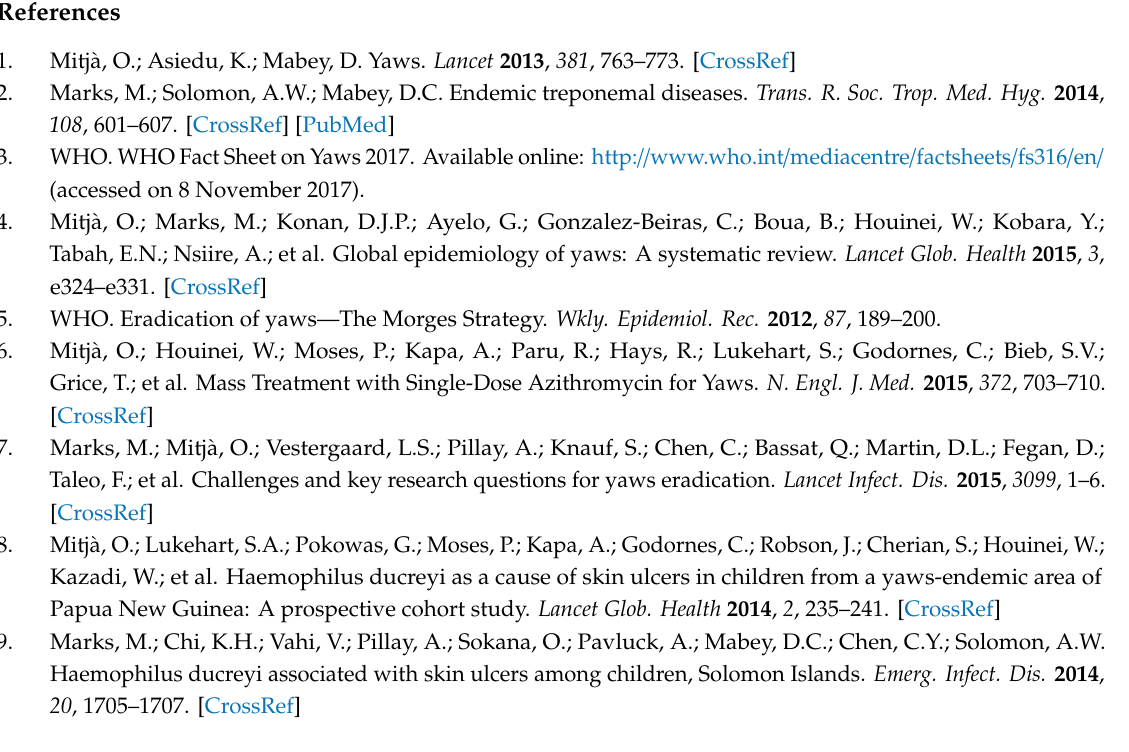
Figure S1: Primer combination testing for PolA of T. pallidum, Figure S2: Primer combination testing for hhdA of H. ducreyi , Table S1: Sequences for all Primers and Probes Used in the Assay Development, Table S2: List of Bacteria and Parasite Species and Strains Used for Determining the Cross-Reactivity of the Duplex RPA